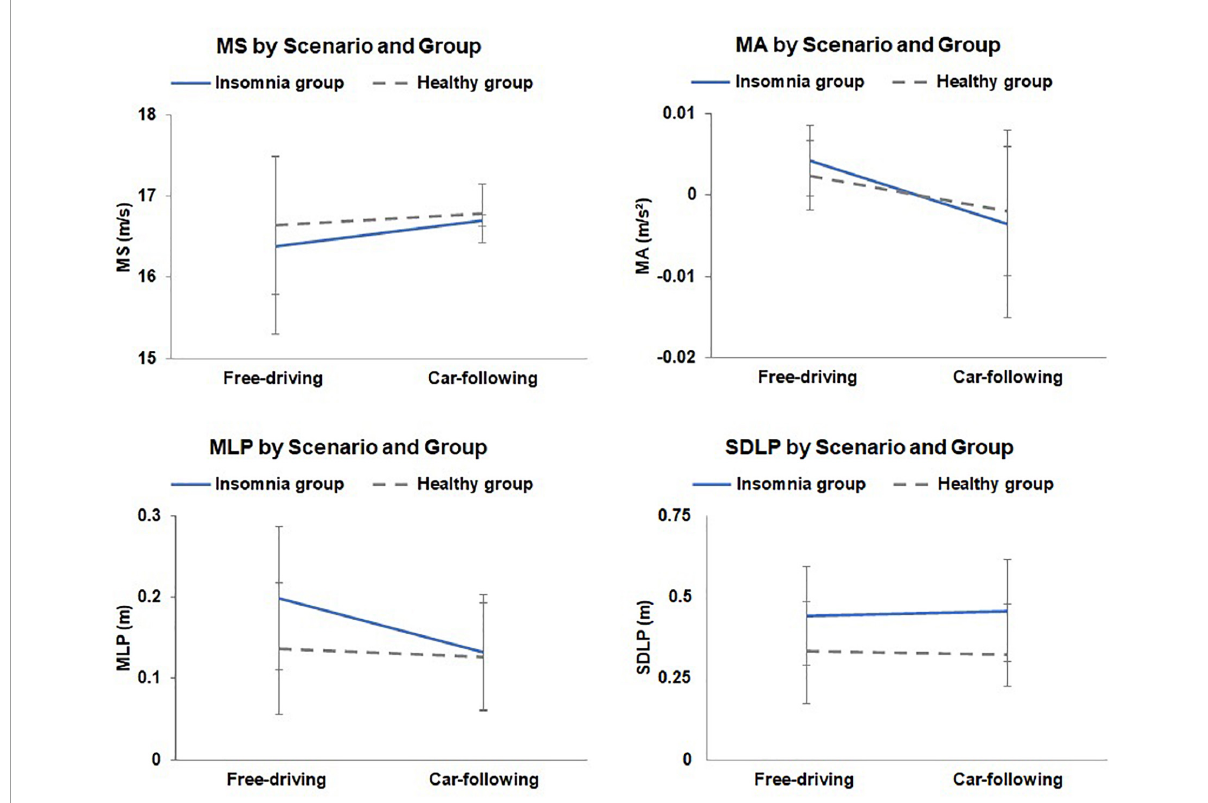
FIGURE3 The mean speed (MS), mean acceleration (MA), mean lateral position (MLP), and standard deviation of lateral position (SDLP) throughout the fatigued driving task for each group. Error bars represent the standard errors of the means.